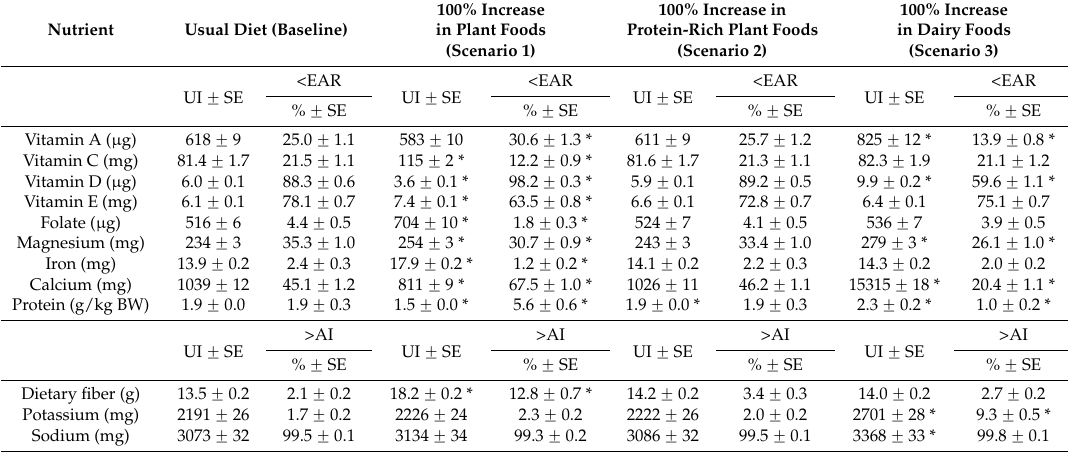
Table 4. Percentage of children and adolescents (2–18 years) from NHANES 2007–2010 with nutrient intakes below the EAR or above the AI based on usual intake, 100% increase in plant foods, 100% increase in protein-rich plant foods, and 100% increase in dairy foods 1